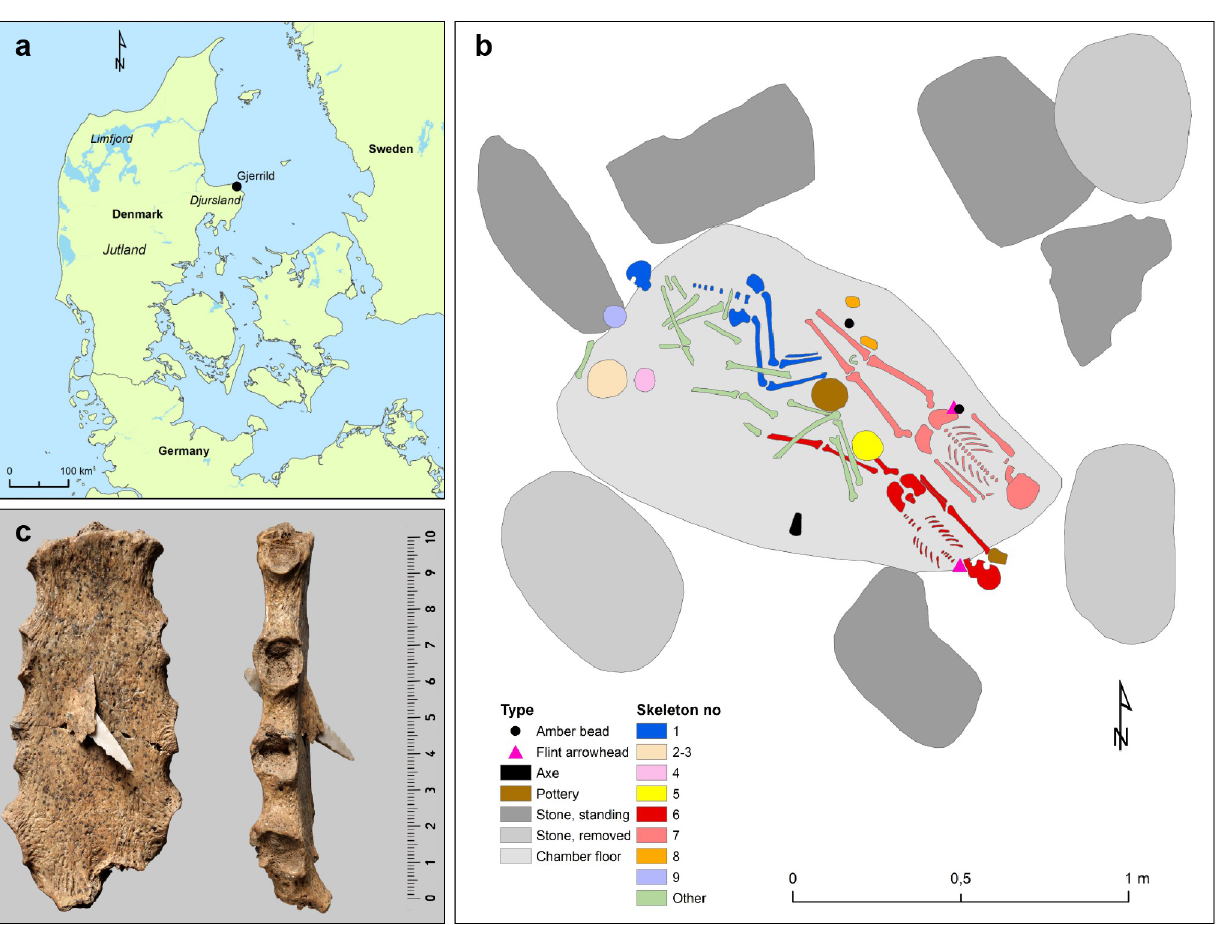
Fig 1. A general overview of the Gjerrild burial monument. A) Map of Denmark with the location of Gjerrild, based on public domain data from Natural Earth (https://www.naturalearthdata.com). B) plan of the Gjerrild chamber tomb with identified individuals. Redrawn by Karl-Go¨ran Sjo¨gren from an excavation plan by C. L. Vebæk. Individual 1: female, 20–25 years old, placed in hocker position. Individuals 2–4: scattered fragments of 3–4 individuals. Individual 5: male child, c. 2 years old. Individual 6: male, 20–30 years, with type D arrowhead in chest bone. Individual 7: male, 40–50 years, with trepanated cranium and with atypical tanged arrowhead plus amber bead by the right hip. Individual 8: male child, 5–6 years old. Individual 9: cranium of male, 40–50 years. C) breast bone of individual 6, fatally penetrated by a flint arrow head. Photo: John Lee, Danish National Museum, courtesy Samantha